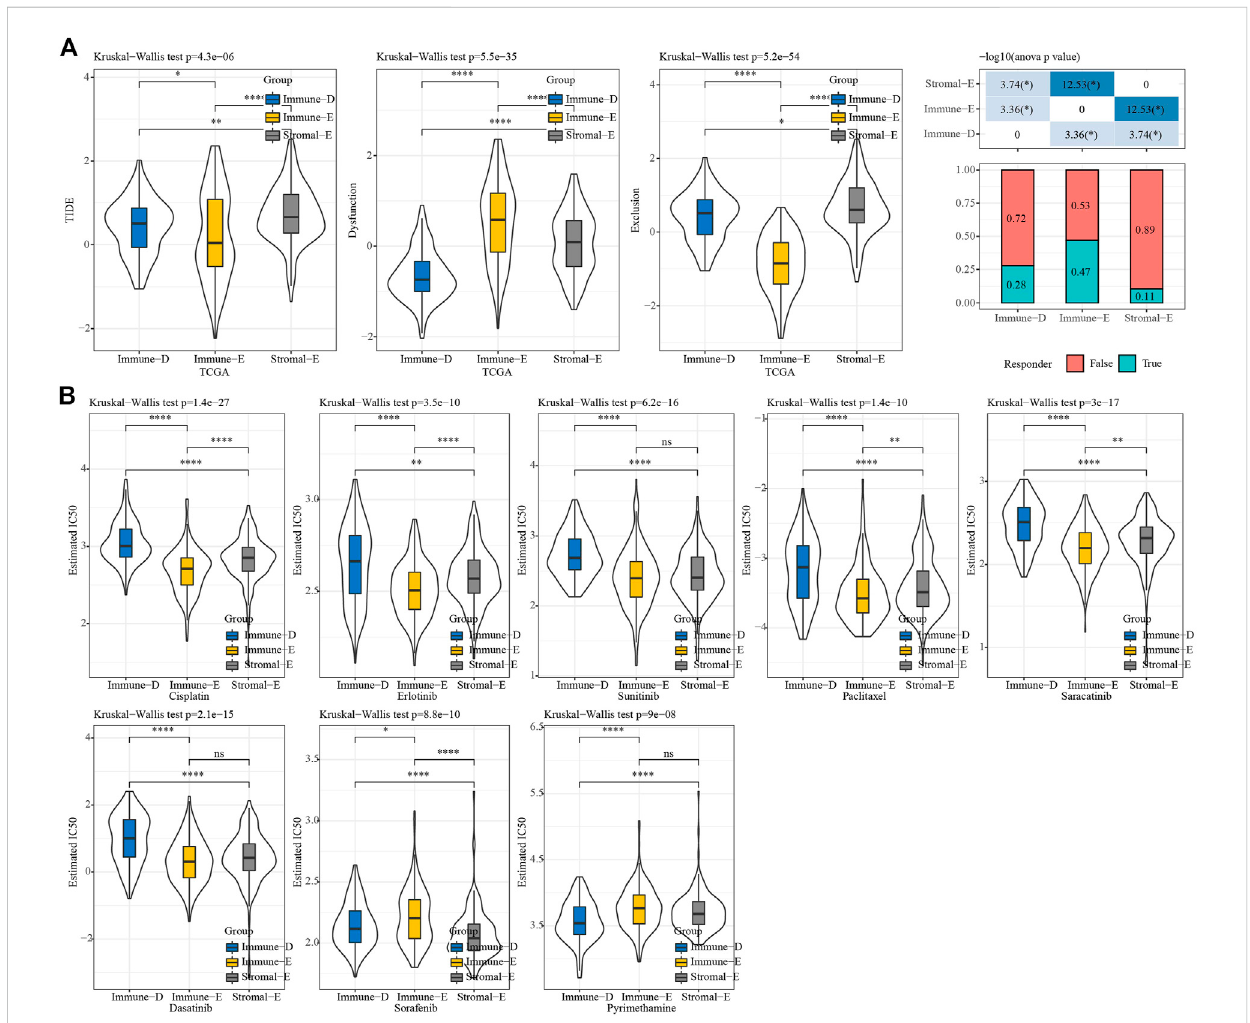
FIGURE 7 TIDE and drug sensitivity analysis. (A) TIDE analysis among the three molecular subtypes. (B) IC 50 analysis of eight drugs among the three molecular subtypes. * p < 0.05; ** p < 0.01; **** p < 0.0001; ns: no signi fi